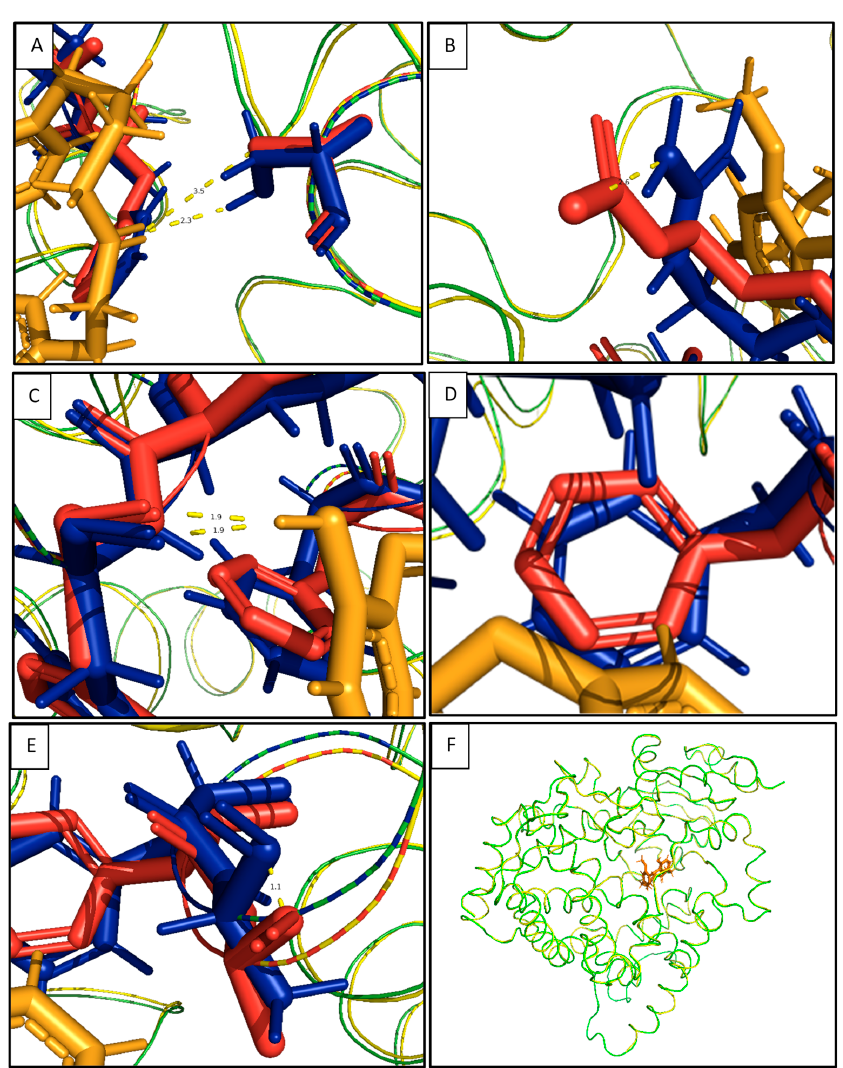
Figure 10. Conformational changes of the interacting residues: ( A ) Ser119, ( B ) Arg212, ( C ) Phe213, ( D ) Phe304, ( E ) Ala305, and ( F ) the overall structural alignment. The Apo state is represented in yellow, while the ligand bound state is shown in green. The Apo state interacting residues are in red, and ligand bound state residues are in